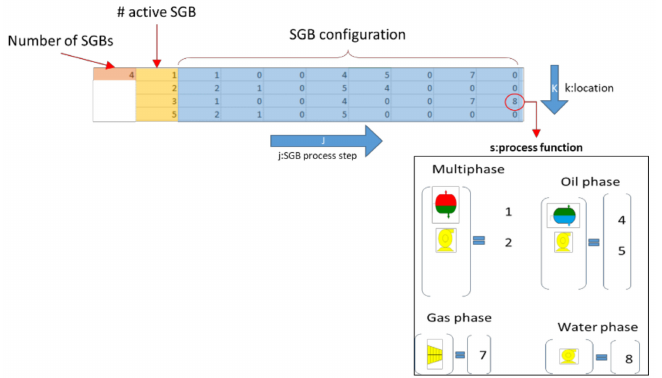
Figure 5. Superstructure identification system.